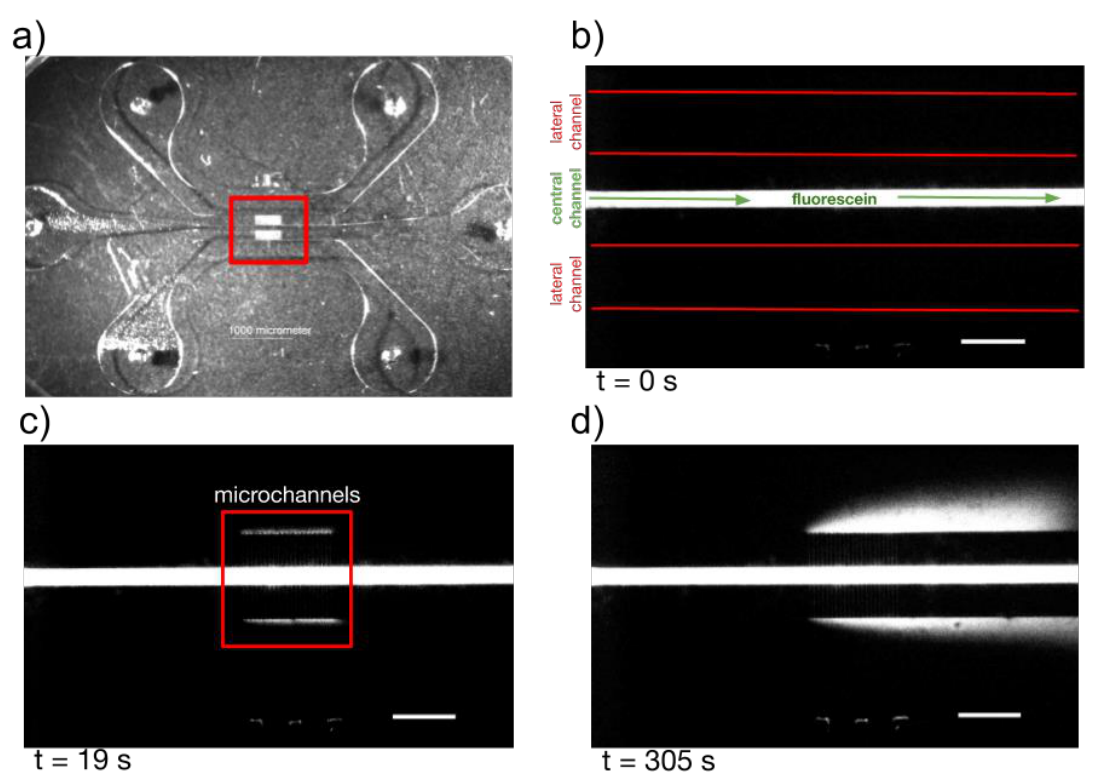
Figure 7. Test of diffusion inside the three-channel microfluidic chip. ( a ) The low-resolution mold for three large channels was made by CNC micromilling (outer channels marked with red lines, central filled with fluorescein in ( b ), the micromold of the smallest connecting microchannels was microfabricated by 2-photon polymerization. ( b ) The channels were first filled with IPA and at time zero, a droplet of fluorescein was deposited at the inlet of the central channel. ( c ) After 19 s, without flow, the fluorescein started to diffuse towards the lateral channels through the connecting microchannels. ( d ) 5 min later, the fluorescein was visible inside the lateral external channels ( d ). Scale bars are all 800 µm.